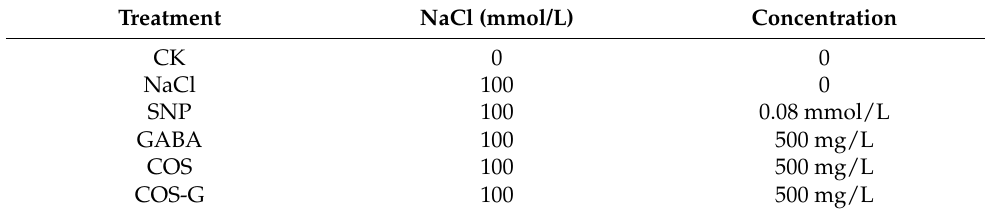
Table 1. Different treatment combinations for wheat